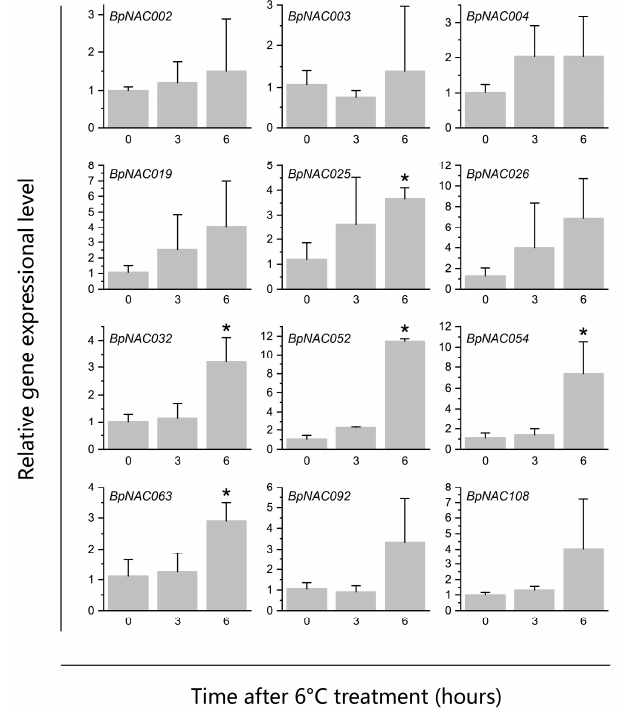
Figure 3. Expression analysis of selected BpNACs genes using quantitative real-time RT-PCR (RT-qPCR). Two-month old plants of birch were incubated at 6 °C for the indicated time. Data represent means ± SD in three replicates. Stars (*) indicate P < 0.05 (T-test).